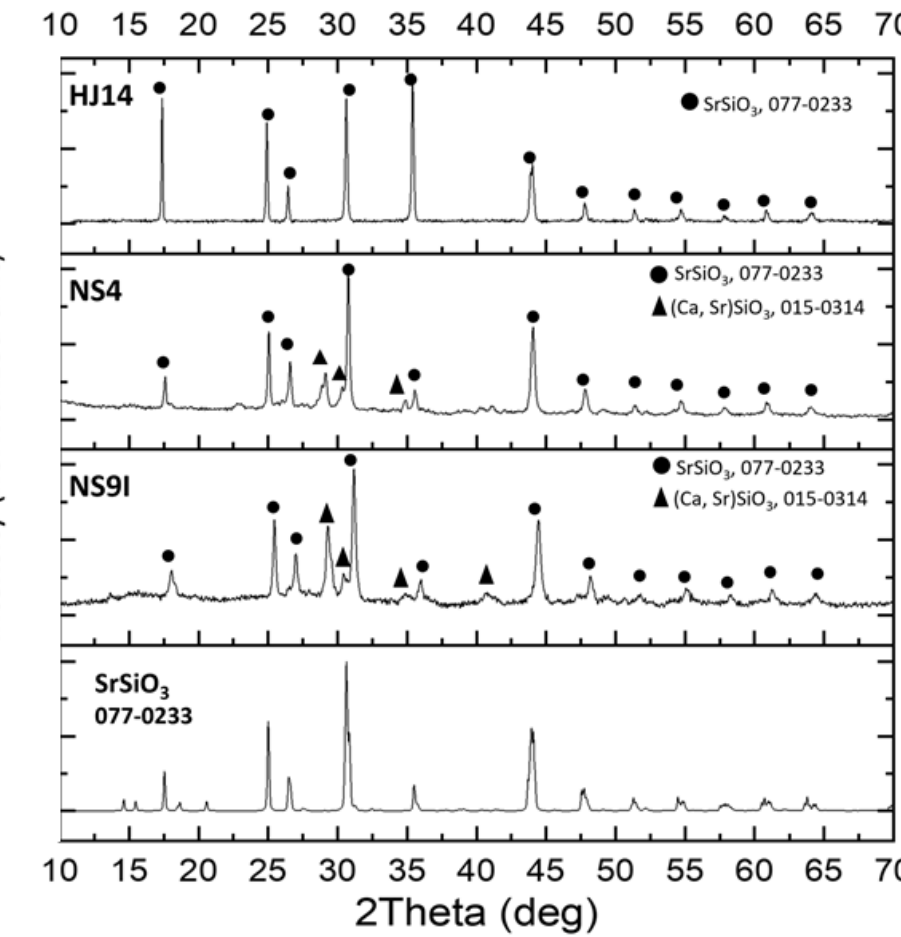
Figure 2. XRD patterns of the HJ14, NS4, and NS9I glass-ceramics after joining SrSiO 3 is also the main crystalline phase in the NS4 and NS9I glass-ceramics. How- ever, two additional peaks (at around 2Theta = 29.4 and 30.4) can be detected and are likely attributable to the main peaks of calcium-strontium silicate (PDF2